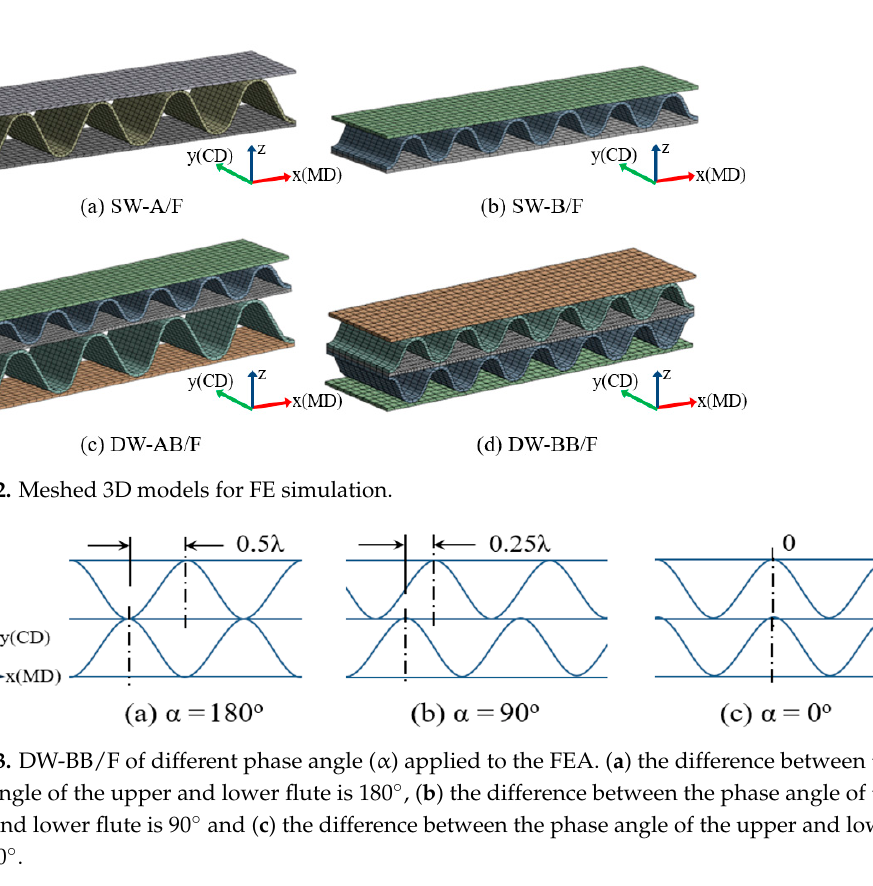
Table 2. Orthotropic material properties of corrugated paperboards used for the FEA [3].